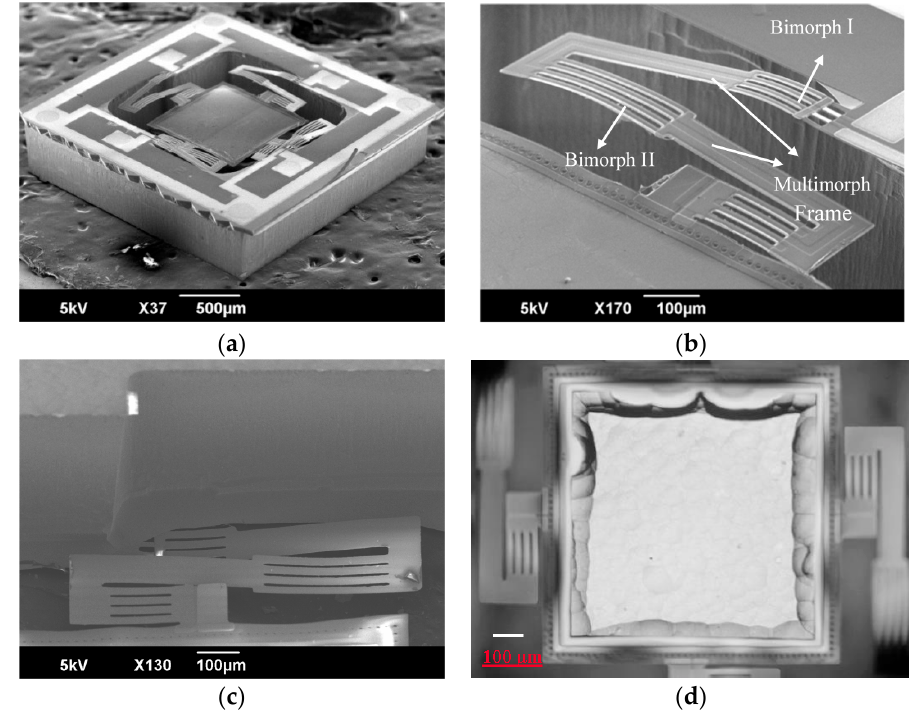
Figure 7. SEM/microscope pictures of the fabricated Cu-W LSF-based MEMS mirror. ( a ) Whole device; ( b ) Close view of LSF actuator from front-side; ( c ) Close view of LSF actuator from backside; ( d ) Optical microscope picture of the backside of the mirror plate.